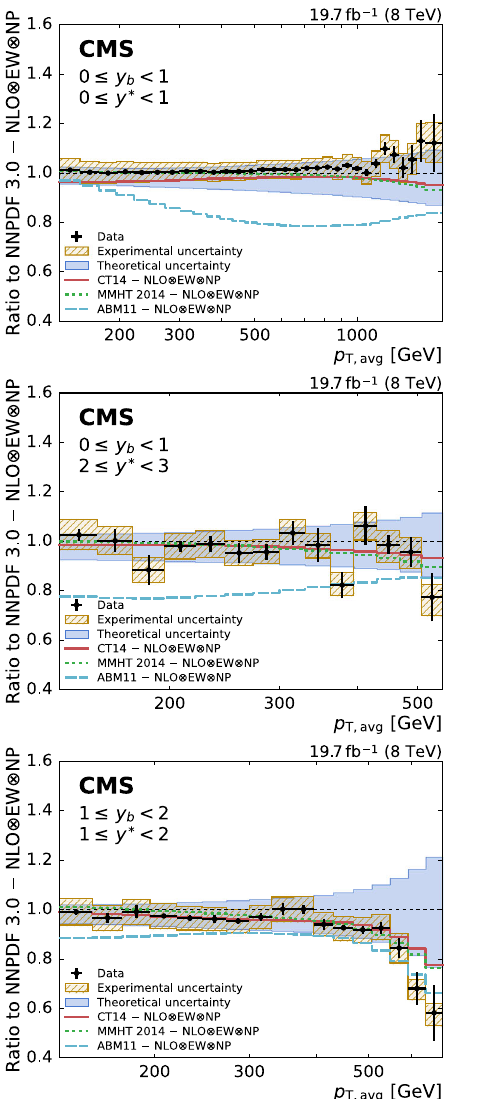
Fig. 7 Ratio of the triple-differential dijet cross section to the NLO- Jet++ prediction using the NNPDF 3.0 set. The data points including statistical uncertainties are indicated by markers, the systematic exper- imental uncertainty is represented by the hatched band. The solid band